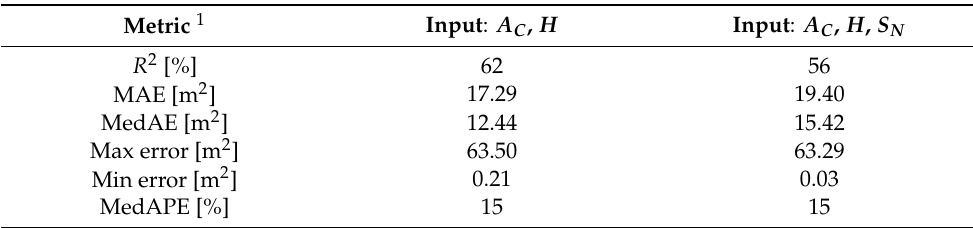
Figure 7. Predictions of the neural networks with 10 hidden neurons of the usable area of buildings in Koszalin, Poland, with a distinction between one- (diamonds) and two-story (dots) buildings. Input features are ( a ) the covered area, the building’s height, and ( b ) also the number of stories. Table 4. Comparison of usable area estimation accuracy of the neural networks for 22 buildings from Koszalin, Poland, with different input